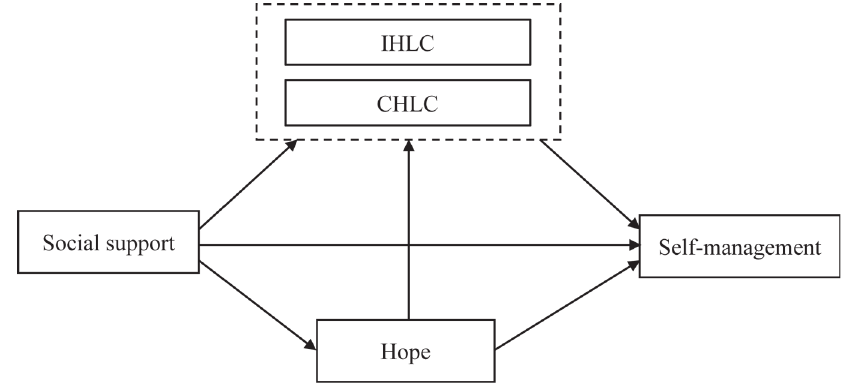
Figure 1. The hypothesis model between social support, HLC, hope, and